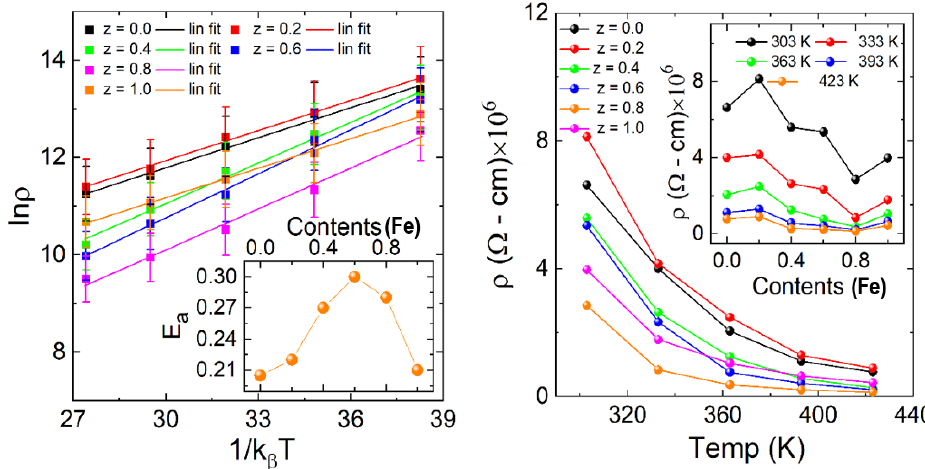
Figure 6. Temperature-dependent resistivity ( left side) and Arrhenius law ( right side) for La 2 Co 1−z Fe z MnO 6 (z = 0, 0.2 – 1.0). Insets represent the concentration-dependent resistivity and calcu- lated activation